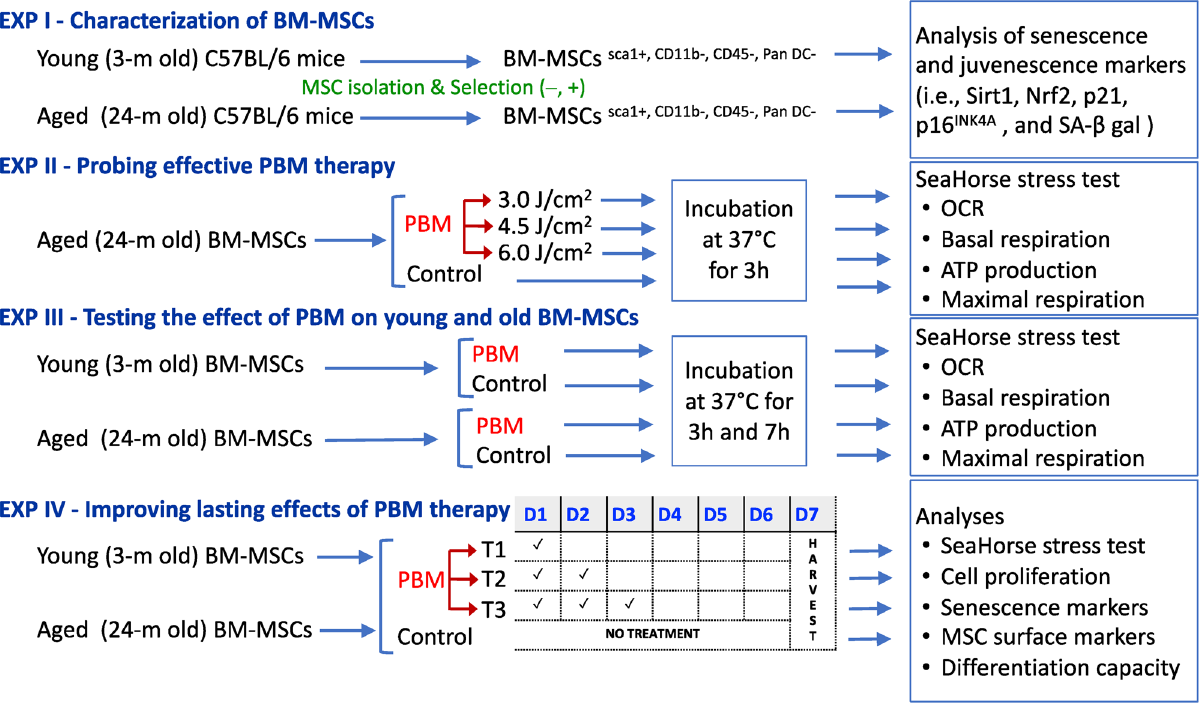
Figure 1. Experimental overview. A total of four sets experiments were performed with different subgroups. Bone marrow mesenchymal stem cells (BM-MSCs) isolated from young and old mice underwent different treatments and were analyzed at the end of each experimental repeat as